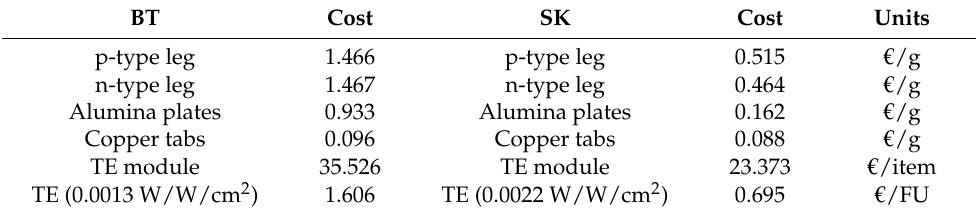
Table 1. Contribution cost for the BT and SK energy harvester.